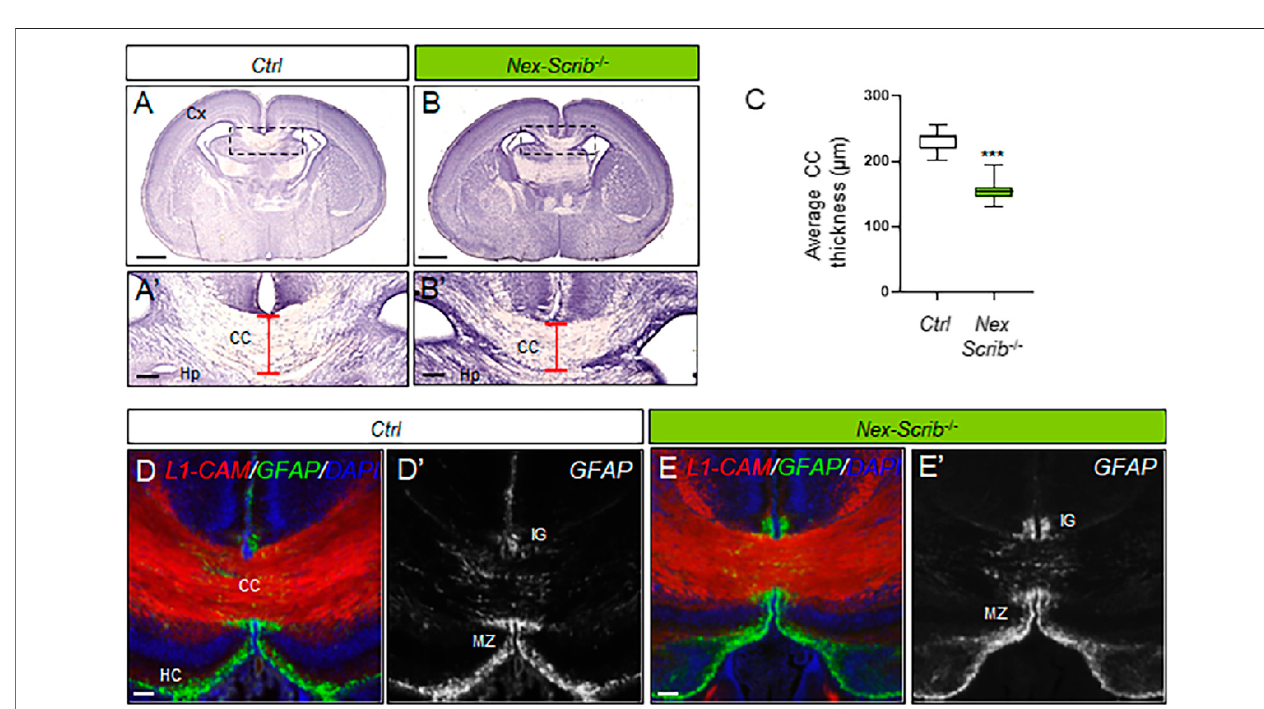
FIGURE 3 | Corpus callosum dysgenesis in Nex-Scrib -/- cKO mutants. (A,B) , Representative hematoxylin staining of coronal sections from newborn Nex-Scrib -/- cKObrains (B) andcontrolbrains (A) atthecaudallevel.Dashedboxesin (A,B) aremagni fi edin (A ’ ,B ’ ) .Scalebar:1 mm. (A ’ ,B ’ ) ,Highermagni fi cationforselectedinsets (boxed areas) from (A,B) illustrating the reduction of corpus callosum thickness in the Nex-Scrib -/- cKO brains (see red brackets). Cx: Cortex, Hp:Hippocampus. Scale bar: 0.1 mm. (C) , Average thickness of the corpus callosum in μ m in newborn Nex-Scrib -/- cKO brains (green) and control brains (white). Statistical analysis via a two-tailed t-test (*** p < 0.01) using respectively 10 and 9 measurements per genotype from 3 independent experiments. Error bars indicate the SD. (D-E ’ ) , Representativeimmuno fl uorescencestainingofL1-CAM(red)andGFAP(green)asamergedimage (D,E) orGFAPonly[ (D ’ ,E ’ ) ,gray]oncoronalsectionsfromnewborn Nex-Scrib -/- cKObrains[ (E,E ’ ) ,green]andtheirrespectivecontrols (D,D ’ ) atthecaudallevel.GFAP-positivemidlinegliastructuresdoformnormallyinNex-Scrib -/- cKO mutants despite CC hypoplasia. Scale bar: 0.1